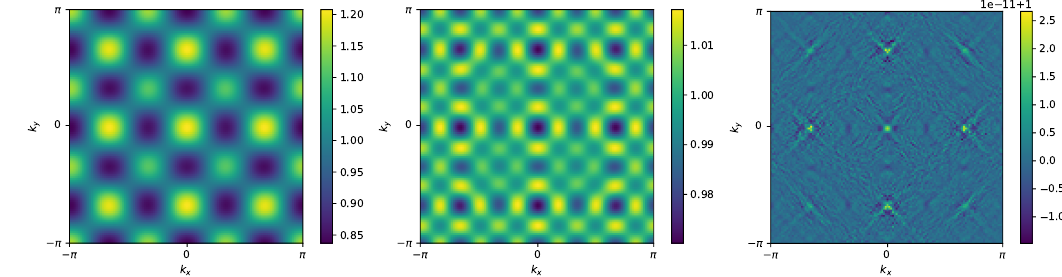
Figure 7: Berry curvature of the original 3-band model of Ref. [ 38 ] (left), after one iteration of the flattening algorithm (middle), and after 10 iterations (right). Note the scales of the colorbars. The curvature is scaled such that average curvature of 1 corresponds to a band with Chern number